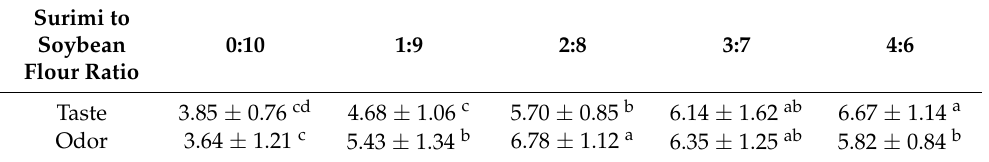
Table 4. Sensory evaluation scores of flavor properties of extrudates with different surimi to soybean flour ratios. Surimi to Soybean 0:10 1:9 2:8 3:7 4:6 Flour Ratio Taste